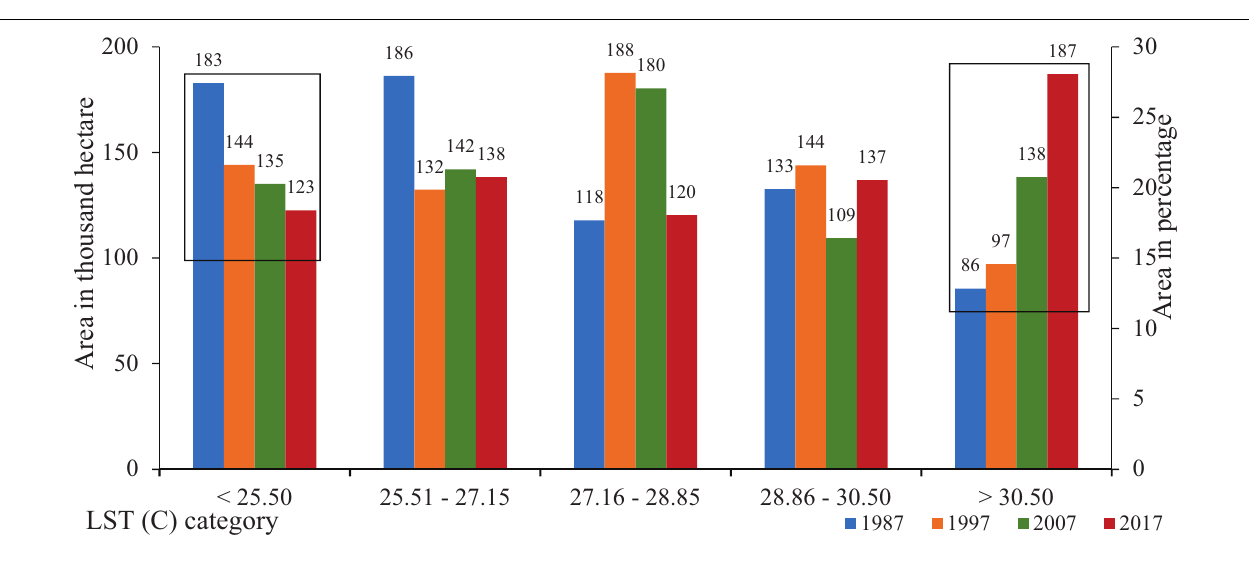
FIGURE 9 | Total area converted in different LST category (1987, 1997, 2007, and 2017).